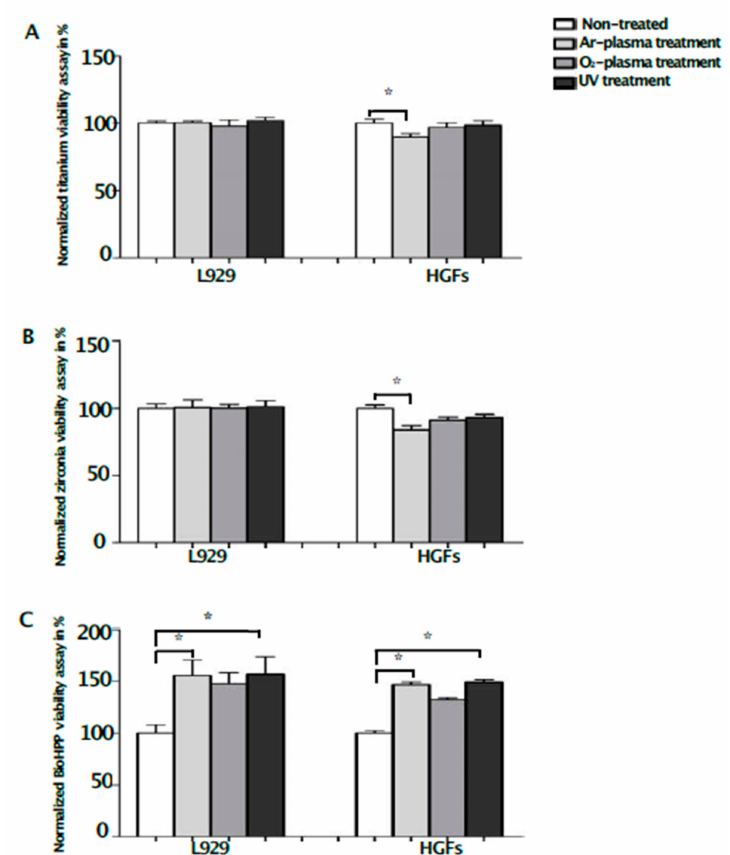
Figure 3. Viability of L929 and HGFs on di ff erent surface-treated titanium, zirconia and BioHPP after 48 h. Viability of L929 and HGFs on controls and surface-treated titanium ( A ), zirconia ( B ) and BioHPP ( C ) disks after 48 h of incubation. While the viability of HGFs on titanium and zirconia was significantly lower after argon plasma treatment, the viability of both used cell lines was significantly increased on BioHPP (* p < 0.05) after argon plasma and UV light treatment, compared to controls. However, the viability of both cell lines was also increased on oxygen plasma-treated BioHPP disks, but di ff erences were not